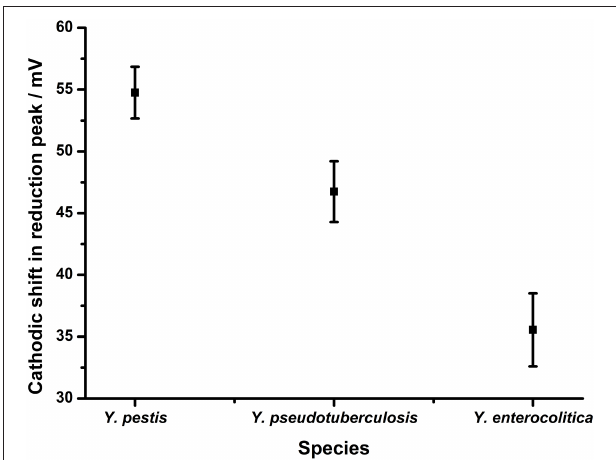
FIGURE 9 | Application of assay design to discriminate between Yersinia serovars. Probe YP1 was hybridized to 24bp strands that were either fully complementary ( Y. pestis ) or containing 2 ( Y. pseudotuberculosis ) or 3 ( Y. enterocolitica ) nucleotide changes respectively. The response in terms of reduction potential shift is shown. All measurements were made by DPV (scan − 0.4V to − 0.75V: 50mV s − 1 ) vs. SCE in 10mM Tris buffer pH 8, 0.5M NaCl. Points represent an average of the responses shown by 12 replicate electrodes across three independent experiments ( n = 4 within each replicate) and error bars are 95% confidence